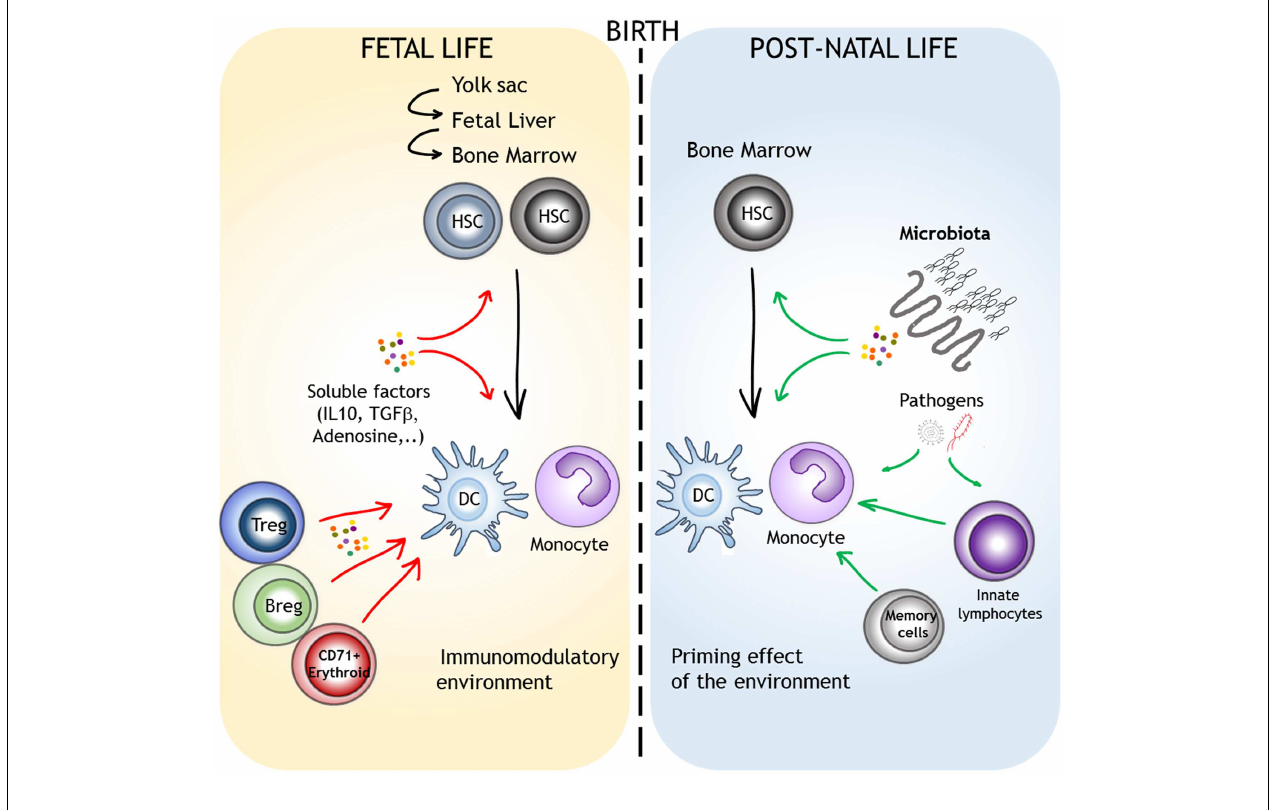
by environmental factors.We depict the role of the materno-fetal immunomodulatory environment (red arrows) and the direct or indirect priming effects of microbial-derived signals that are encountered after birth (green